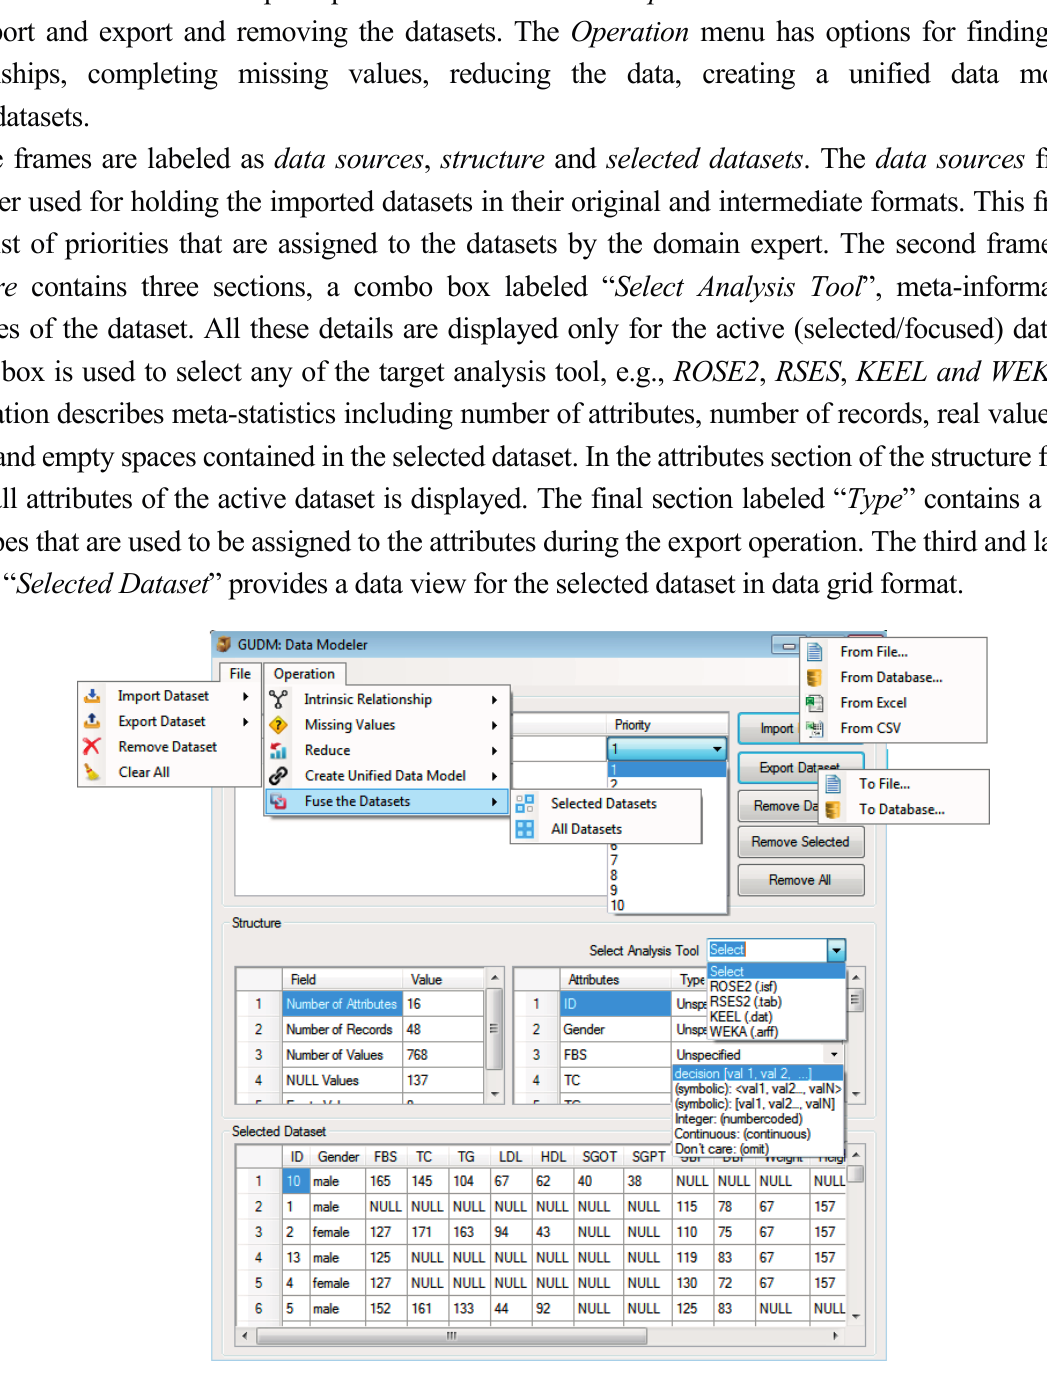
Figure 4. The “data modeler” launch interface with all the supported